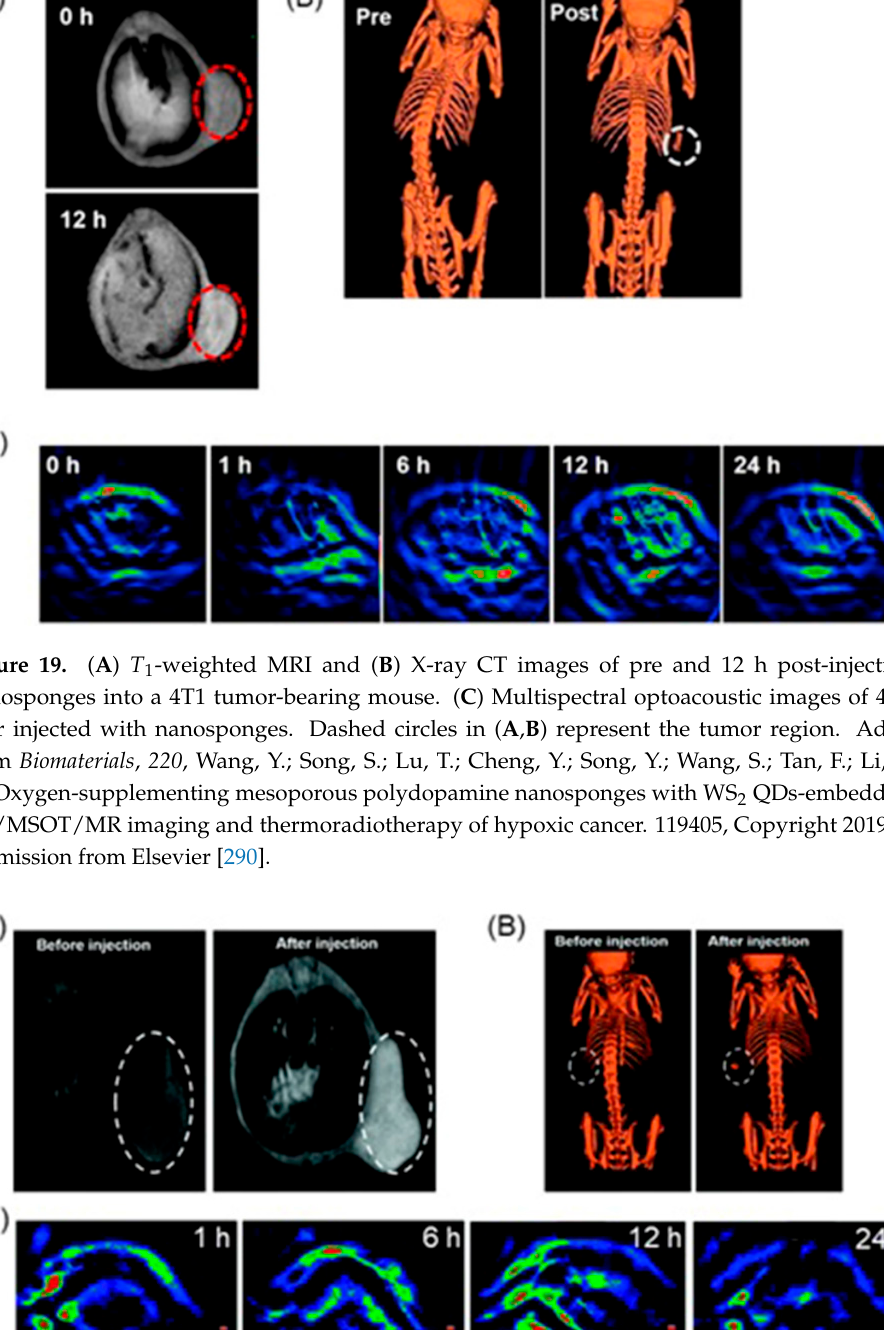
Figure 20. ( A ) T 1 -weighted images, ( B ) X-ray CT images, and ( C ) multispectral optoacoustic images of 4T1 tumor before and after injection with nanoparticles. Dash circles of ( A , B ) represent the tumor region. Adapted from Methods in Enzymology, 657 , Xu, S.; Shi, X.; Chu, C.; Liu, G. A TME-activated in situ nanogenerator for magnetic resonance/fluorescence/photoacoustic imaging, 145–156, Copyright 2021, with permission from Elsevier